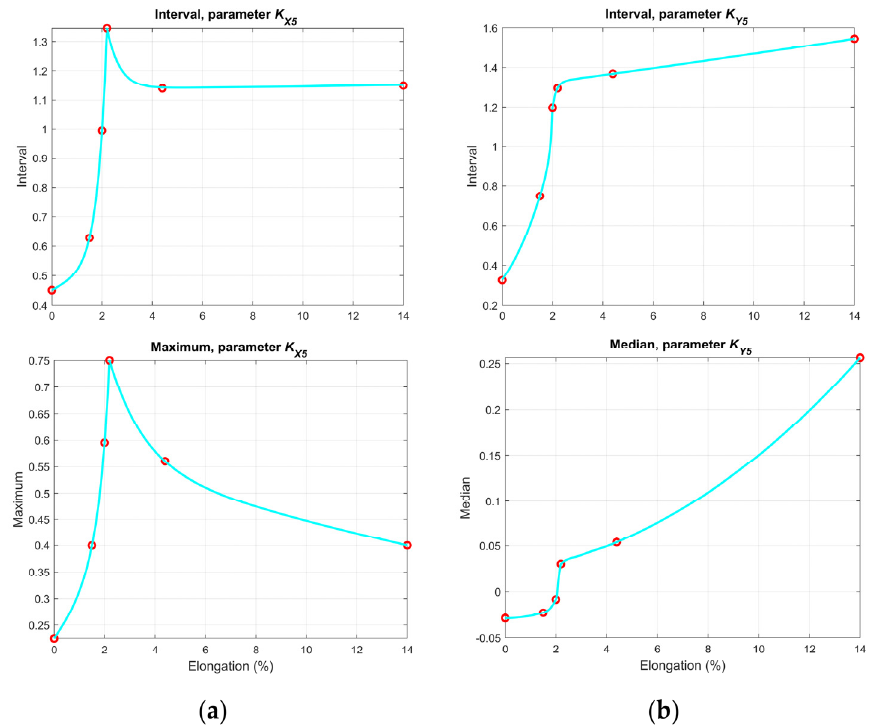
Figure 11. Chosen statistical values of the K A 5 parameter for the: ( a ) x -axis direction; and ( b ) y -axis direction.